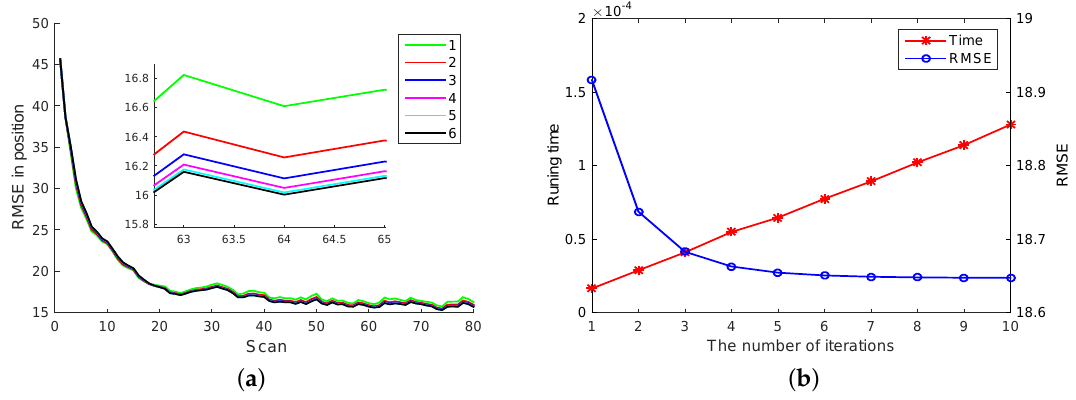
Figure 3. RMSE and running time of PEKF-VB ( a ) RMSE with different number of iterations ( b ) The relationship between iteration and mean RMSE, running